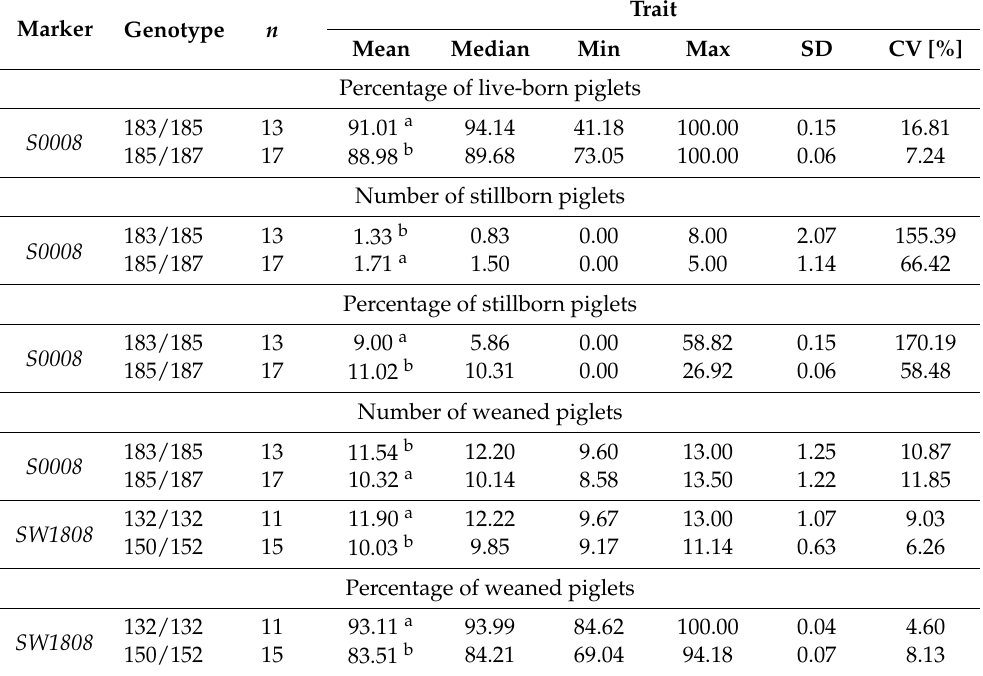
Table 7. Reproductive performance indicators of Polish Large White sows, depending on their genotype and the analyzed microsatellite markers. Marker